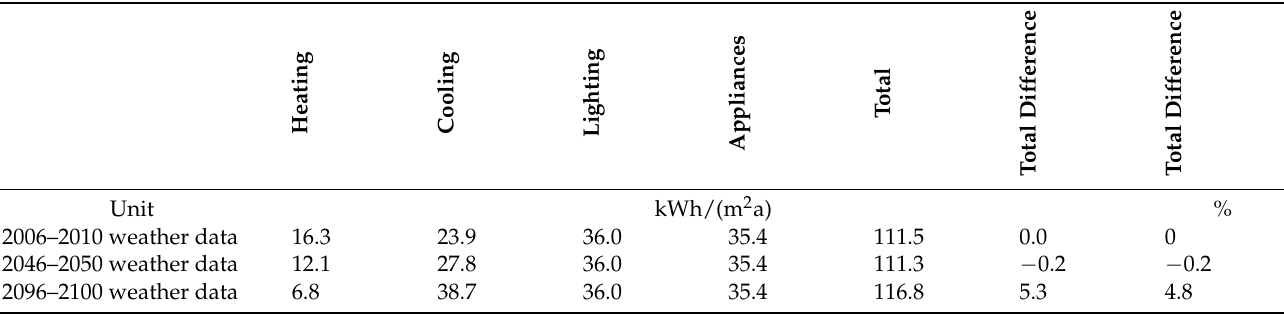
Table 5. Simulation results—site